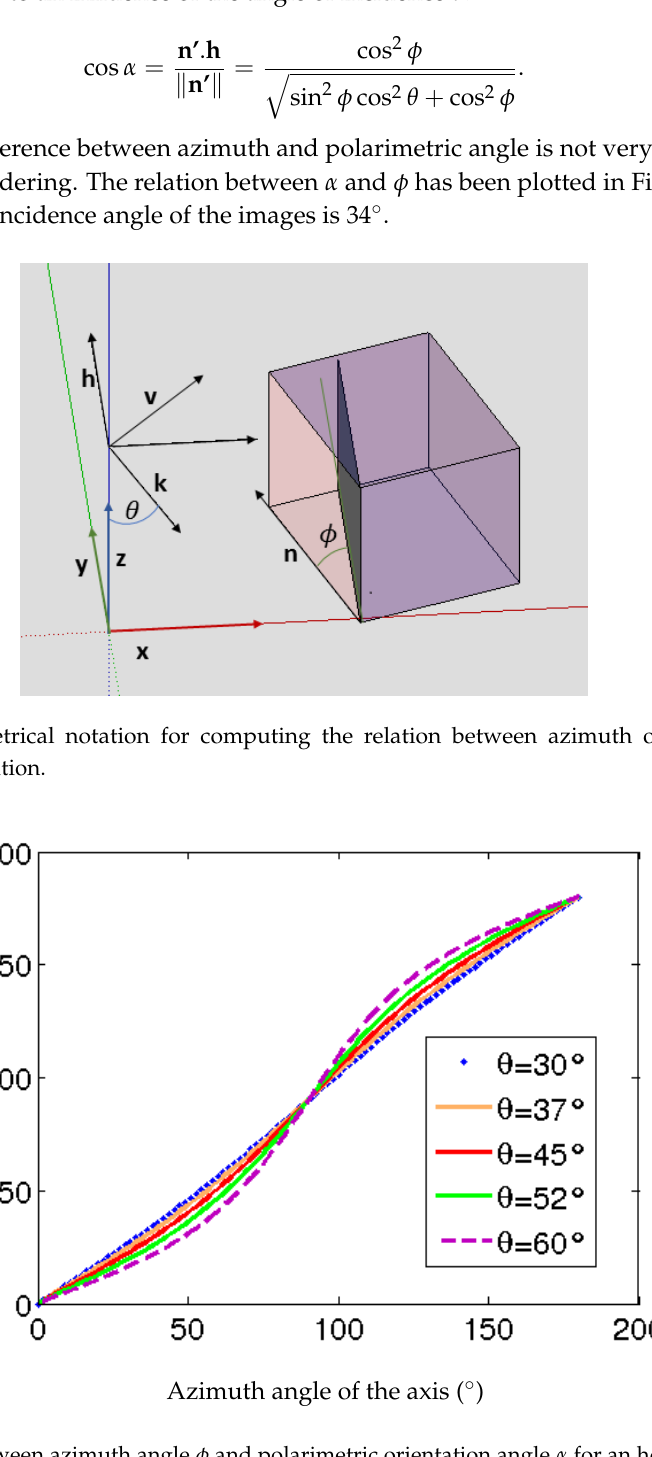
Figure 13. Link between azimuth angle φ and polarimetric orientation angle α for an horizontal vector and several incidence